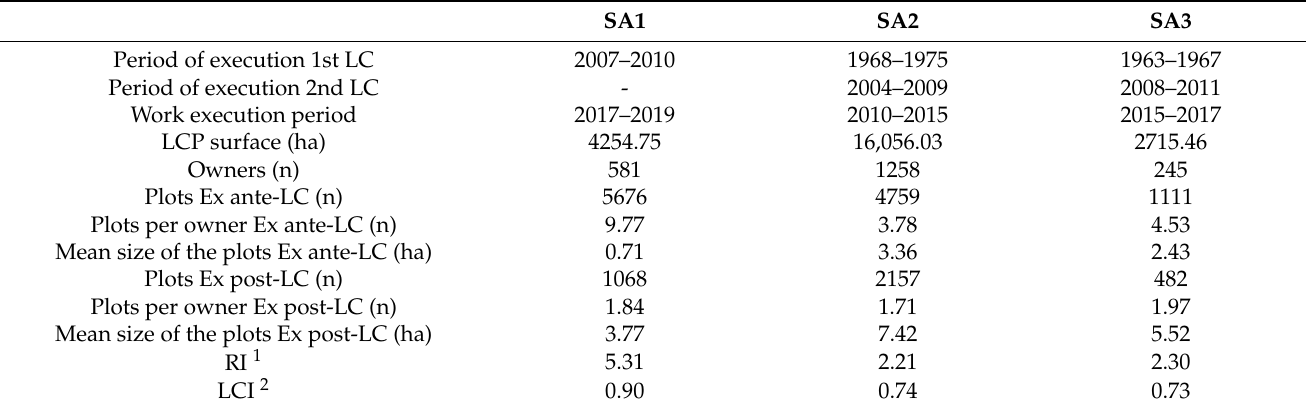
Table 1. Main parameters and technical indexes of each